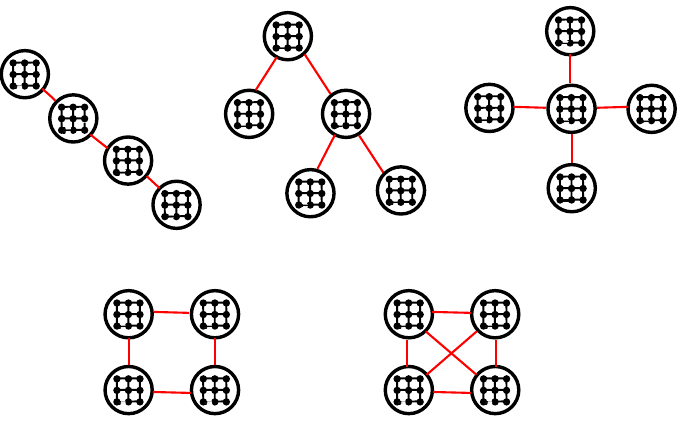
Figure 2. Schematic representations of a network of networks (NON) and several examples of its possible structures. Connectivity links (black) exist within networks, and dependency links (red) connect different networks. Examples include a line ( top left ), a tree ( top center ), a star ( top right ), a random regular network of networks where each network has m = 2 dependencies ( bottom left ) and a random regular network of networks with m = 3 ( bottom right ). After